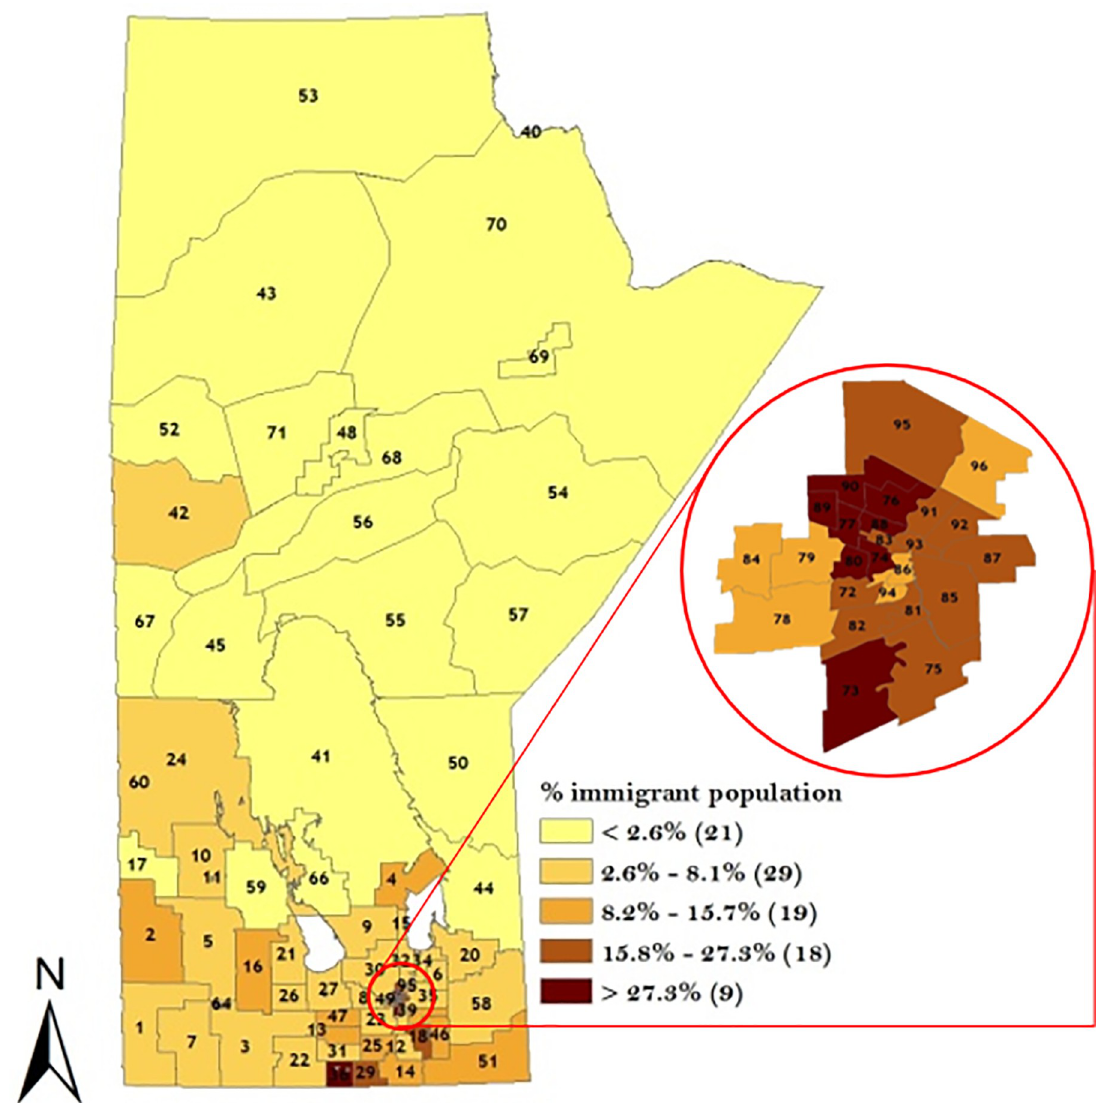
Fig 4. Geographical distribution of immigrant population across the 96 RHADs based on 2016 Canadian Census data. Numbers in the map are the district labels from 1 to 96. Values in parenthesis represents the counts in each distribution category.